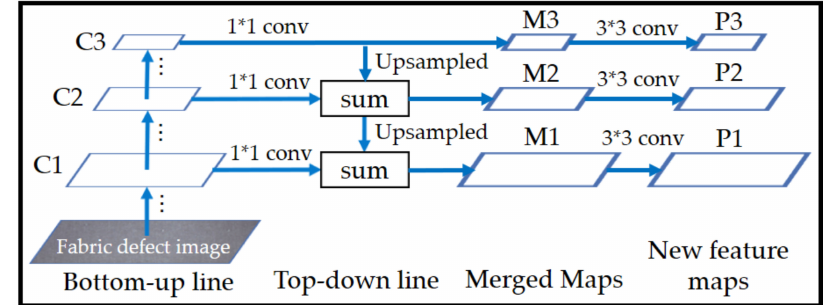
Figure 2. The schematic of features extraction in the PRAN-Net.